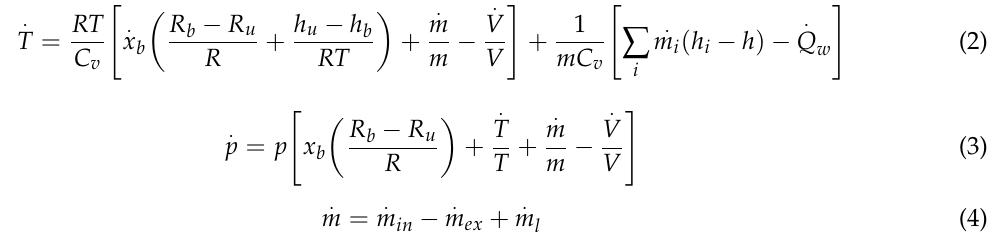
Figure 5. Included angle between two arms.